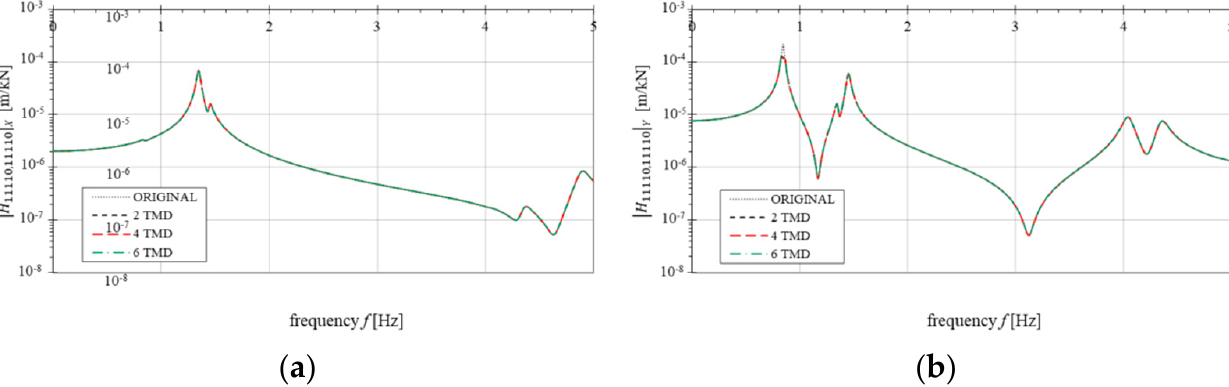
Table 7. Optimal